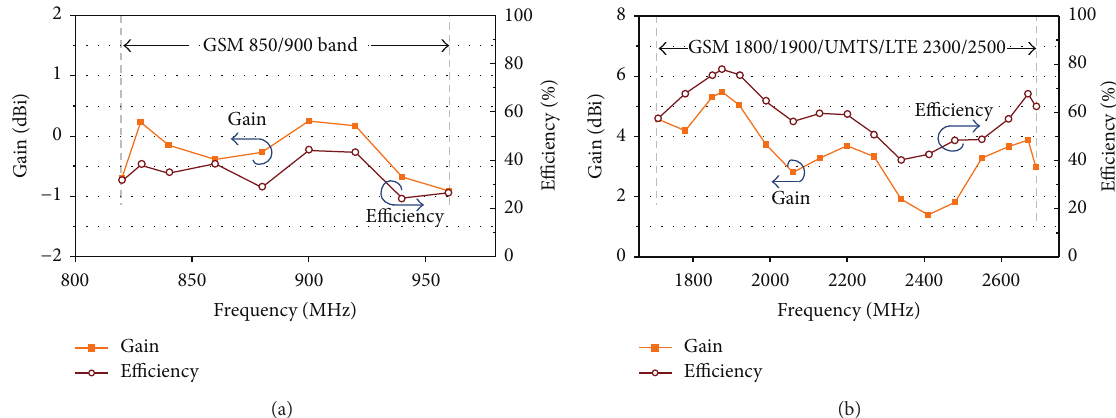
Figure 11: Measured antenna gain and radiation efficiency of the proposed antenna. (a) Low-frequency band. (b) High-frequency band.